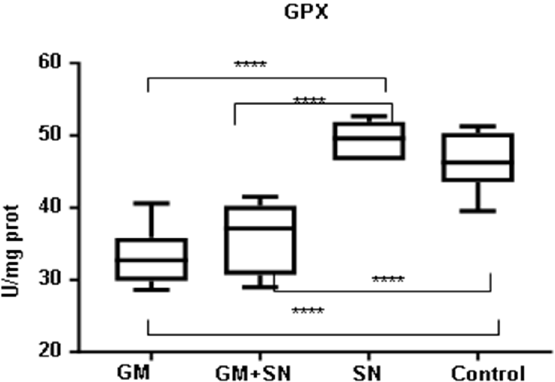
Figure 6. Glutathione peroxidase (GPX) level in the investigated groups (**** p < 0.0001). GM—gentamicin group, GM+SN—gentamicin and Sambucus nigra group, SN— Sambucus nigra group, Control—control group (no treatment).